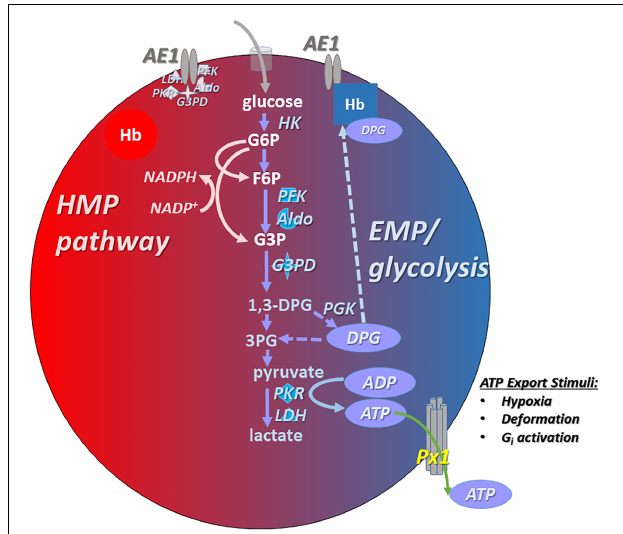
FIGURE 1 | Simplified schema describing ATP generation and export from human RBCs. Glycolysis via the Embden–Meyerhof pathway ( EMP ; in blue on right side of the RBC cartoon) is the principal path to ATP generation in RBCs. EMP activity and ATP (and DPG) generation are favored under low-oxygen conditions, in which membrane-resident AE1 (anion exchanger 1, aka band 3) binds deoxygenated hemoglobin (Hb), freeing up the glycolytic enzyme complex (metabolon) that associates with AE1 when not bound by Hb (i.e., when Hb is oxygenated; pink symbols in upper left of the cartoon RBC). ATP is exported basally, and hypoxia or RBC deformation increase ATP export. Pannexin 1 ( Px1 ) appears to be necessary for O 2 - and deformation-responsive export of ATP from the RBC. The exported ATP can act to limit the adhesivity of RBCs to endothelial cells, effect vasodilation, and may have anti-permeability (Kolosova et al., 2008) and other roles. In oxygenated RBCs, activity of the hexose monophosphate ( HMP ) pathway is favored because EMP enzymes are sequestered to AE1, freeing up shared substrate and generating NADPH that provides the reducing equivalents necessary to power antioxidant systems in the face of high O 2